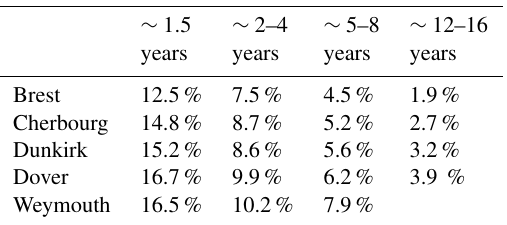
Table 1. The explained variance expressed as a percentage of total variance of monthly extreme surges. The lowest frequency of ∼ 12– 16 years is not observed in